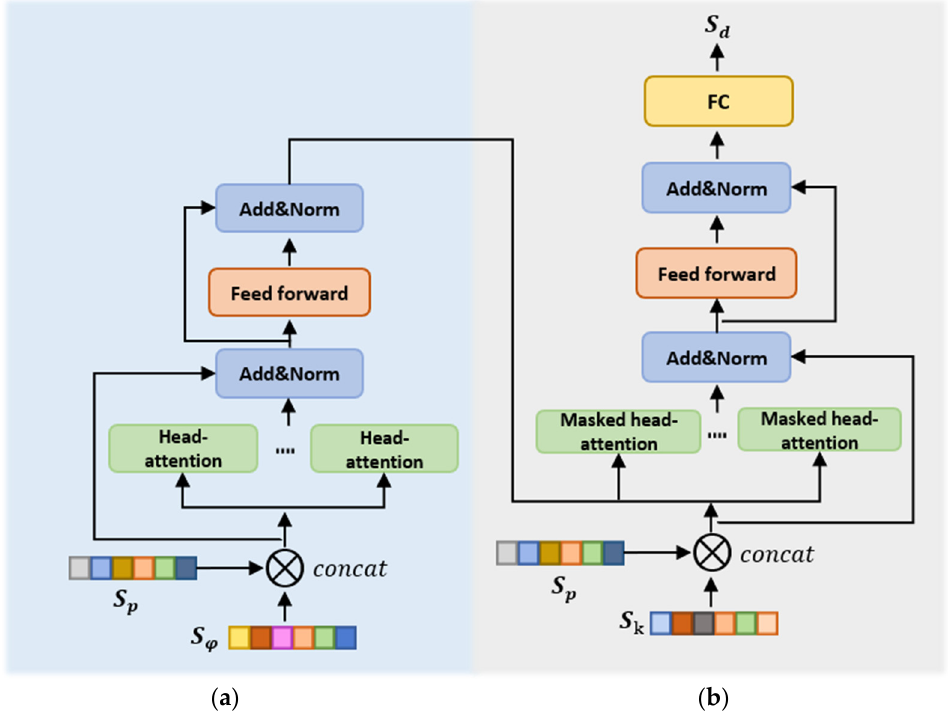
Figure 3. Transformer encoder and transformer decoder module. S ϕ , S p , and S q represent the sequence of feature, position, and query. The ⊗ represent the concat of the sequence. ( a ) Encoder module ( b ) Decoder module.